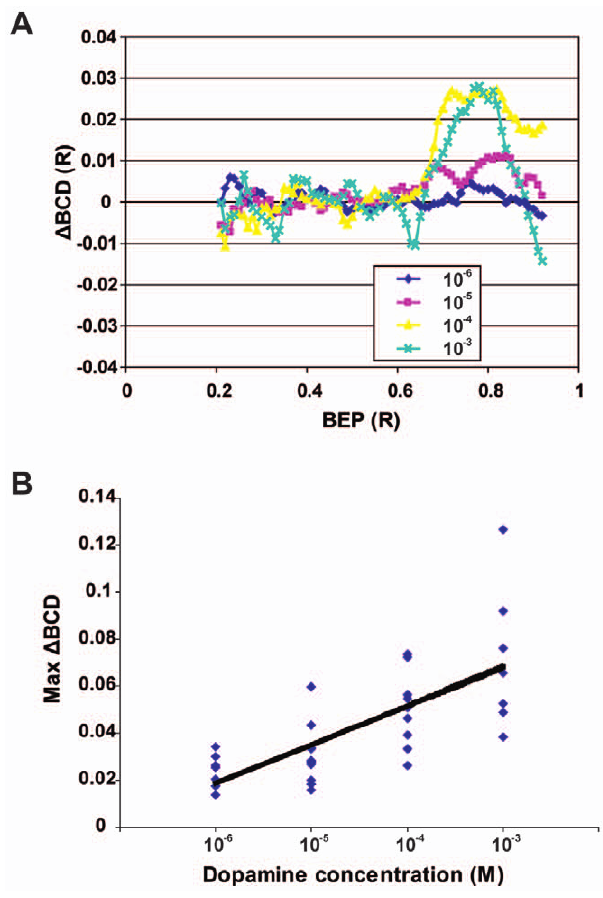
Figure 1. Dopamine decreases the refractive power in the lens periphery. (A) The mean D BCD curves describe the difference between the treated and untreated lenses from all animals (see Methods and Materials). Positive D BCD values indicate a decrease in refractive power i.e. an increase in BCD in the treated lens compared with the corresponding control lens from the same animal. The curves are truncated at 0.2 lens radius (R) and 0.95 R because the scanning method has low accuracy close to the optical axis and in the outer periphery of the lens [30]. These regions contribute little to the image because of a small effective aperture (central region) and reflection at the lens surface (peripheral region; [31]). Note from the mean D BCD curves that dopamine decreased the refractive power in the lens cortex, from 0.60 R and outward. The mean D BCD increased in BEP 0.60–0.95 R when treated with increasing concentrations of dopamine. The curves represent the mean D BCDs from 34 animals (10 2 6 : n=7, 10 2 5 : n=11, 10 2 4 : n=9, 10 2 3 : n=7). (B) Linear regression on max- D BCD as a function of dopamine concentration gave a slope with the r 2 value 0.457 that differed significantly from 0. Max- D BCD is the largest difference in BCD between the control lens and the treated lens measured at BEP 0.55–0.95 R